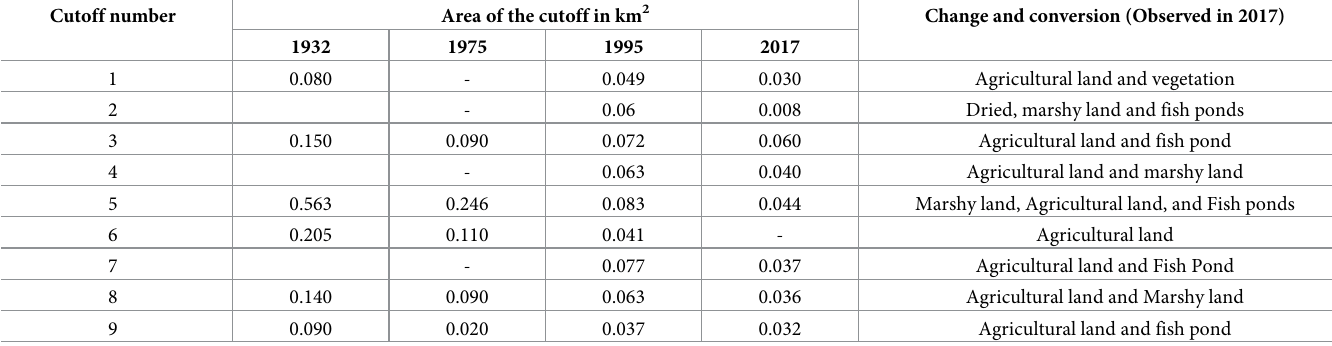
Table 5. Change of the area under cutoffs during the time of the study. Cutoff